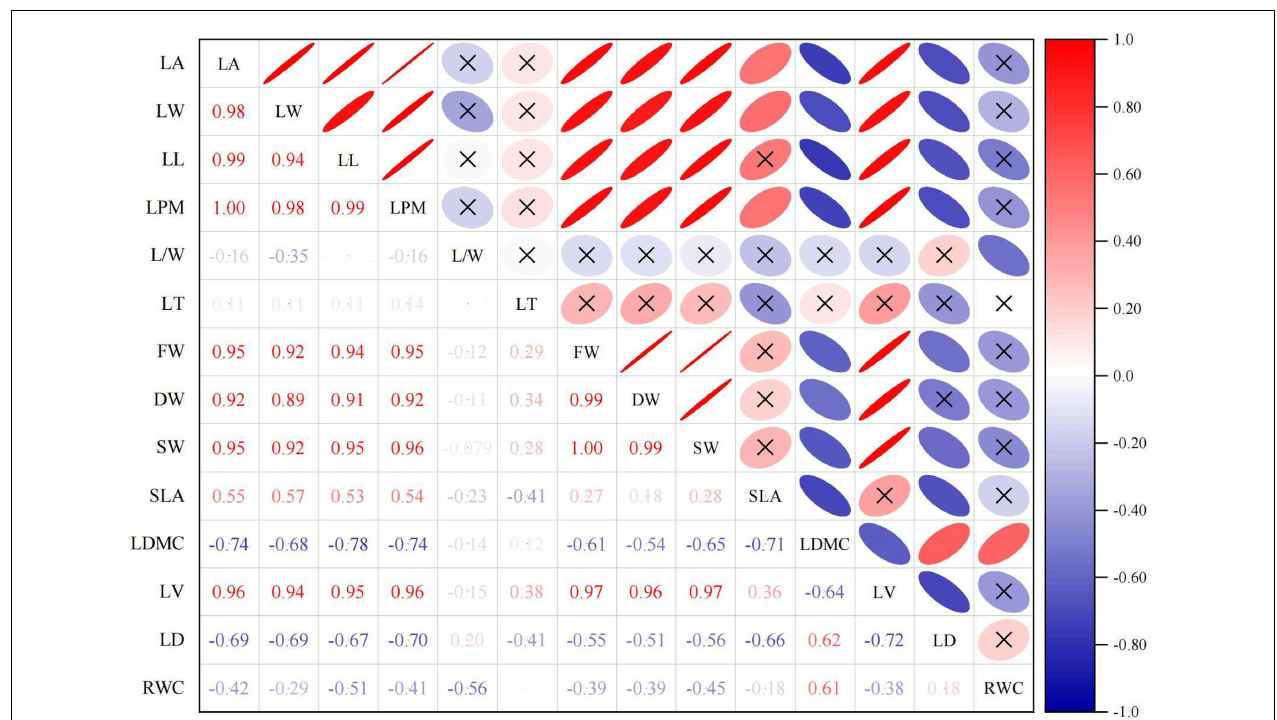
FIGURE 3 | Relationships between leaf functional traits